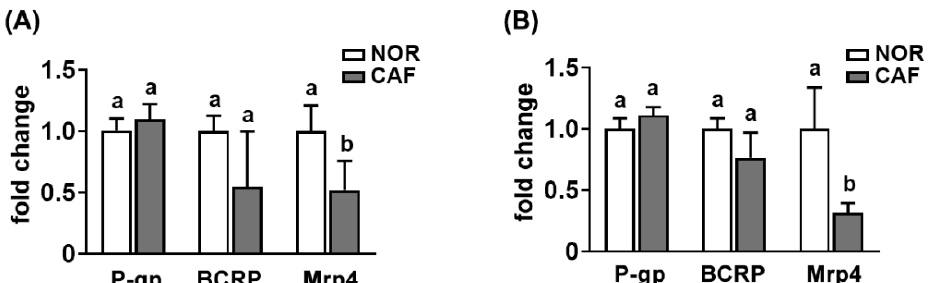
Figure 6. Effect of caffeine (CAF) on the P-gp, BCRP, and Mrp4 expression in the intestines of mice treated with vehicle (NOR) or caffeine (CAF). ( A ) Effect in the small intestine. ( B ) Effect in the large intestine. The transporter expression was assessed by qPCR. Data are shown as the mean ± S.D. ( n = 6). Means with same letters are not significantly different ( p < 0.05).